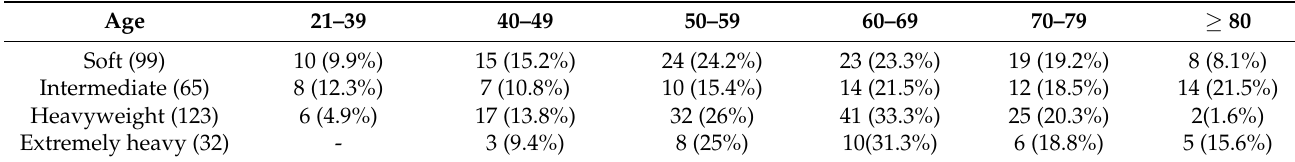
Table 2. Distribution by age and severity of the